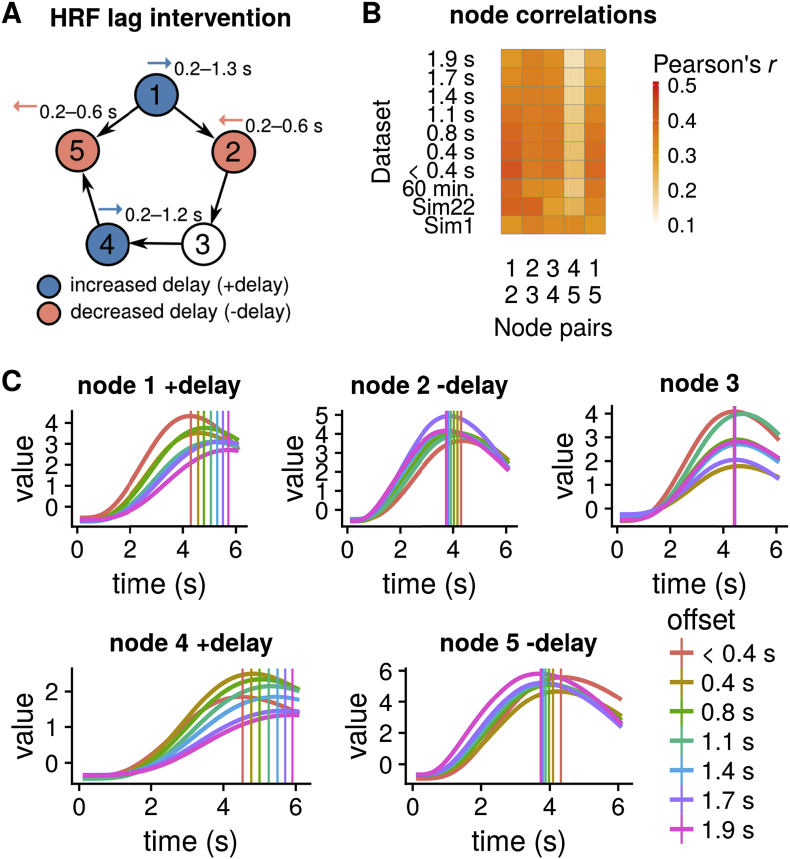
(A) Systematic interventions at four of the five nodes with either increased (node 1 and 4) or decreased HRF delay (node 2 and 5). We created seven simulations with a total offset between two nodes from 0.4 to 1.9 s (B) Pairwise node correlations in the different simulations. (C) Signal output at the 5 nodes showing the BOLD amplitude for the seven interventions where different DCM forward model parameters were used to shift peaks of the HR response, with colors from red (<0.4 s offset) to pink (1.9 s; maximal intervention). Vertical lines indicate average time to peak after stimulus onset for each intervention type.